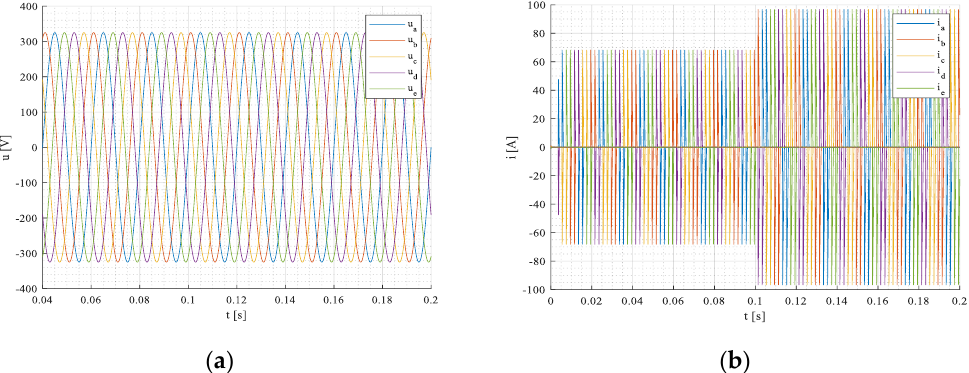
Figure 16. Phase voltages ( a ), currents ( b ) in 𝑎, 𝑏,𝑐, 𝑑,𝑒 - coordinate system during transient. Voltage and current on the DC side of the rectifier under step change of resistive load are shown in Figure 17a,b.